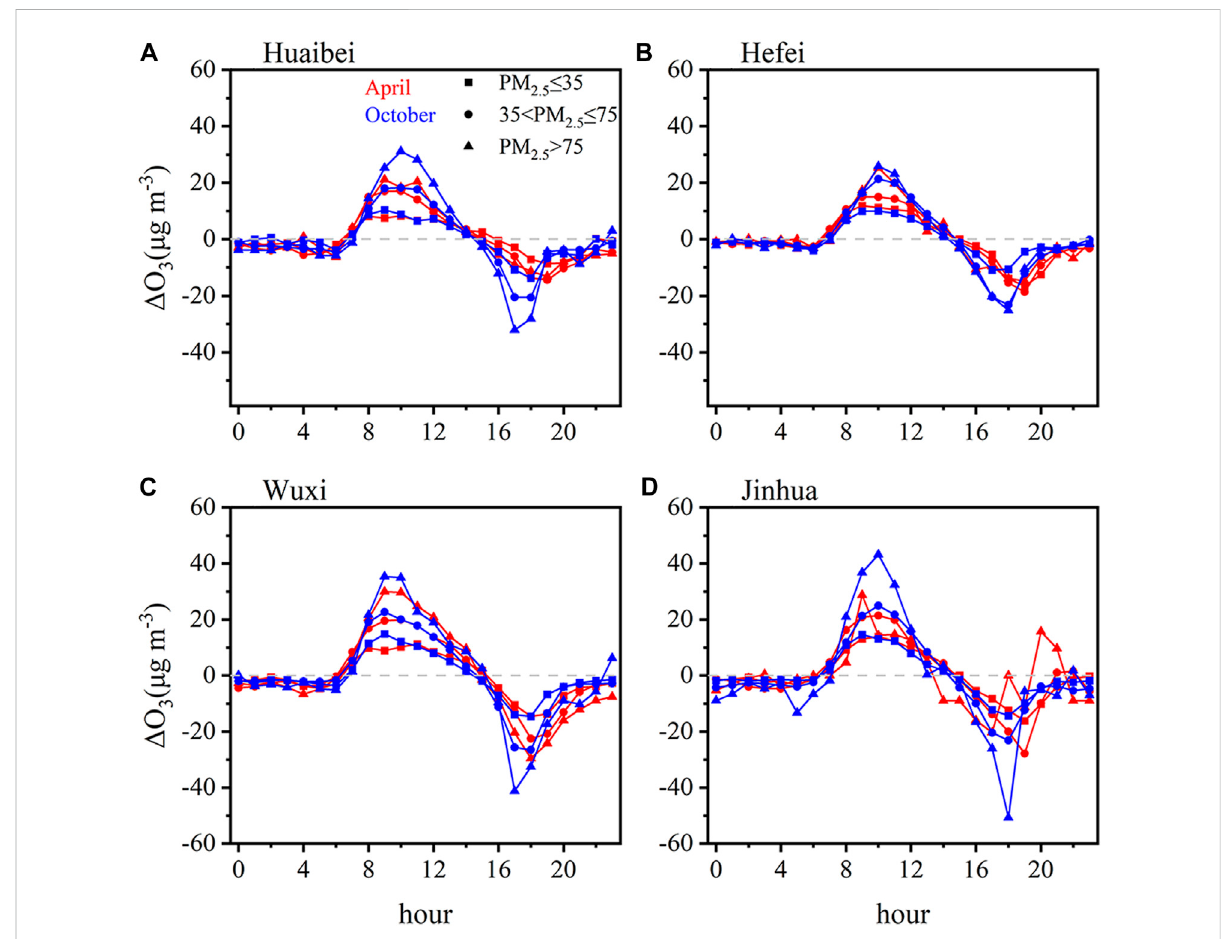
FIGURE 8 Diurnal variationsof O 3 increment (next minus previous) at three PM 2.5 levels in (A) Huaibei, (B) Hefei, (C) Wuxi, and (D) Jinhua citiesin Apriland October from 2015 through 2021. Positive and negative indicate the production and loss of